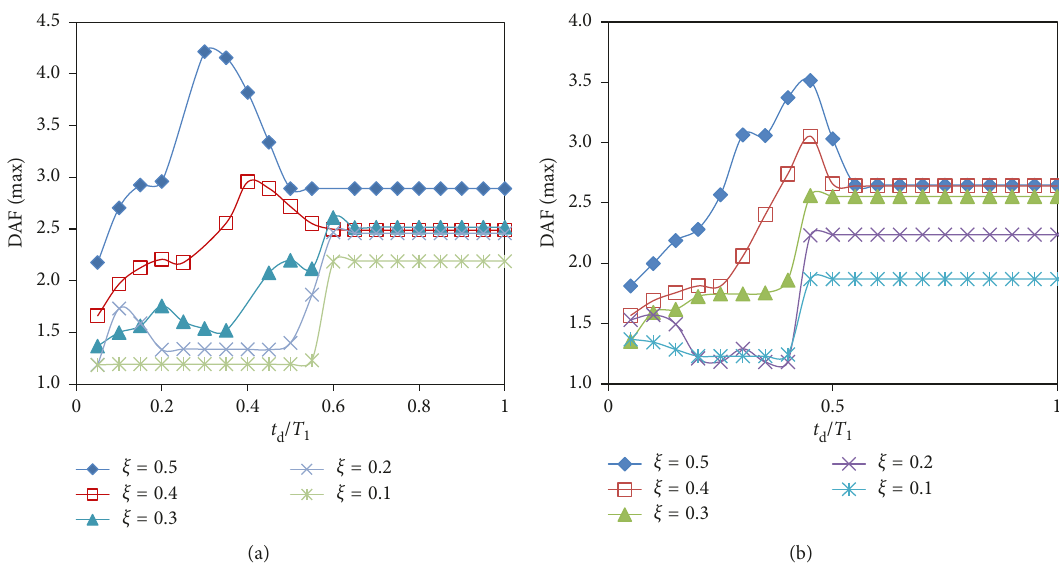
Figure 11: Maximum DAF of shear force of bridge columns under rectangle impact load at different positions. (a) F-F. (b) F-H. Table 3: The calculated DAFs of shear force based on proposed practical formula. Method